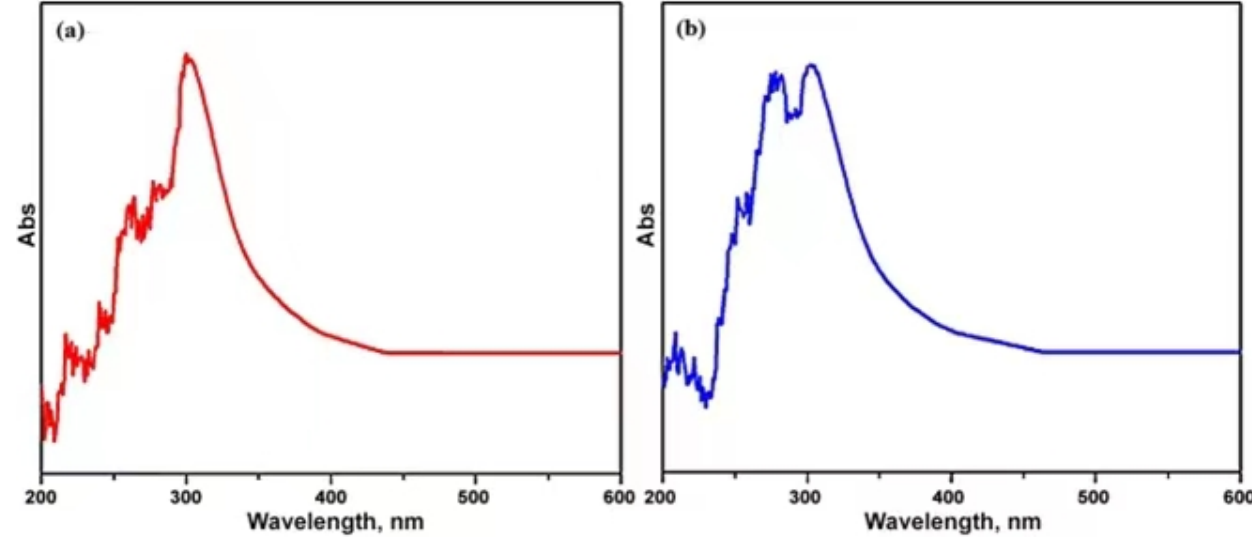
Figure 7. UV ‐ visible absorbance of ( a ) normal water and ( b ) magnetic